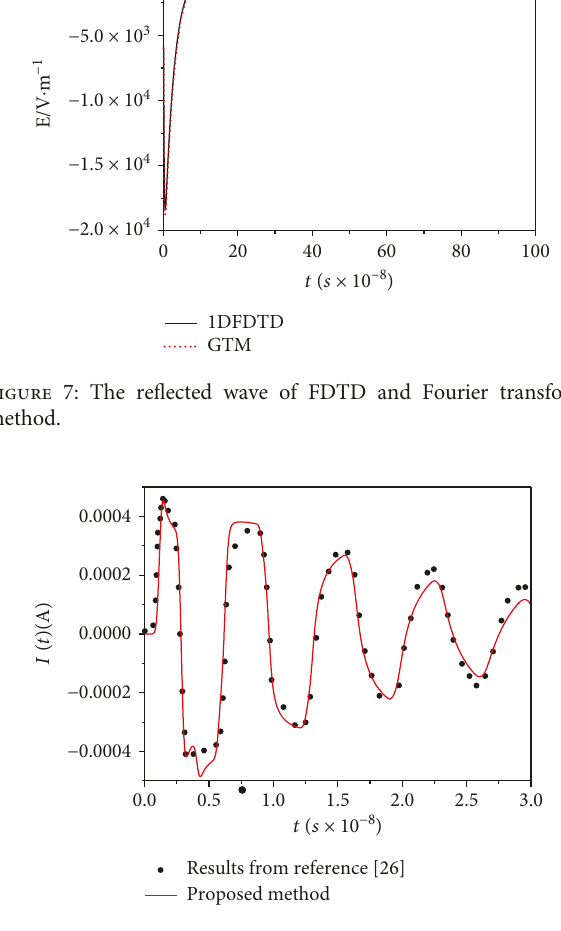
Figure 8: Induced current of the thin wire excited by pulse over lossy ground